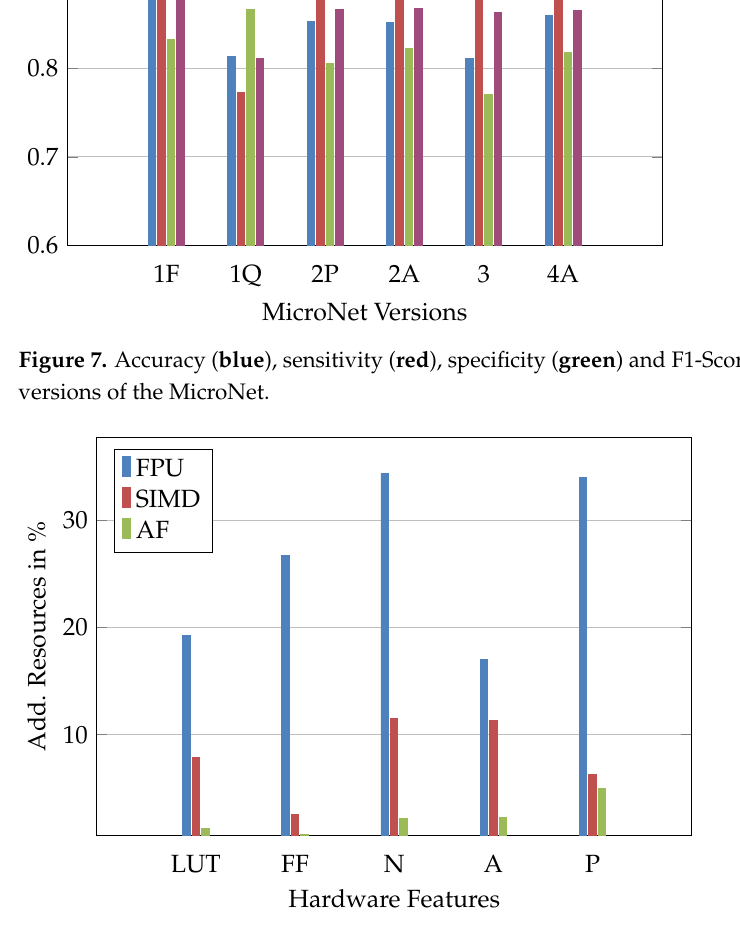
Figure 8. Additional look-up tables (LUT), flip-flops (FF), NAND equivalents (N), silicon area (A) and power (P) needed for the SIMD accelerators (SIMD), the accelerators for the activation functions (AF) and the floating point unit